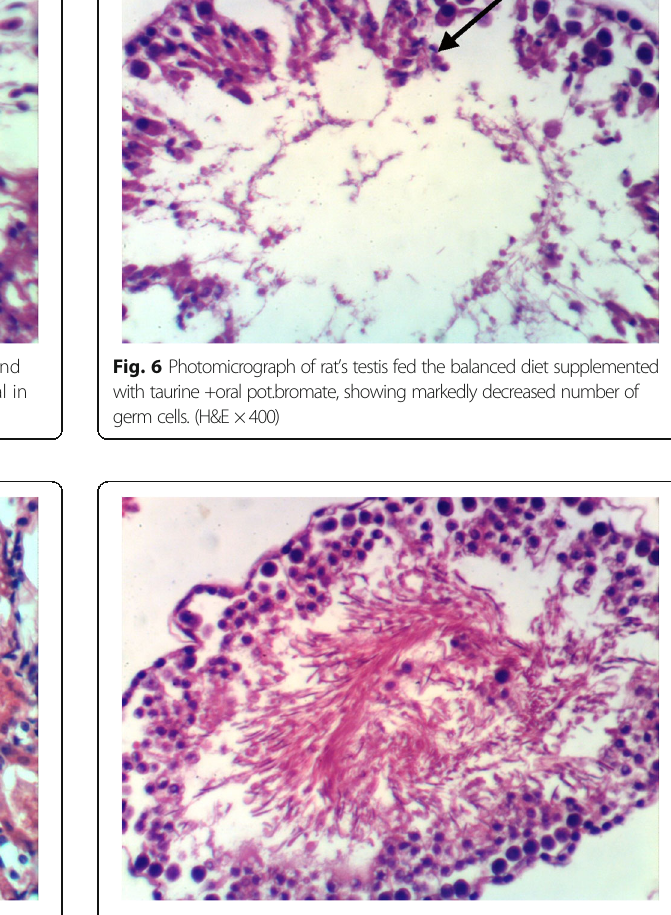
Fig. 7 Photomicrograph of testis of rat fed the balanced dietsupplemented with taurine +oral pot.bromateshowing detached germ cells, although the seminiferous epithelium is partially recovered (H&E ×400)